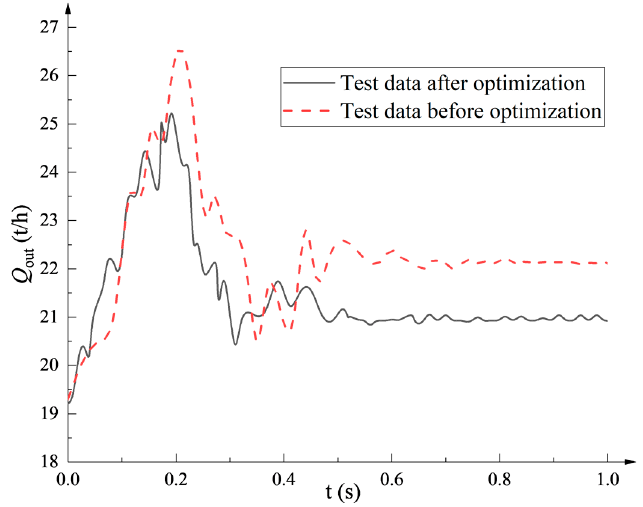
Figure 24. Dynamic characteristics test data of valves before and after